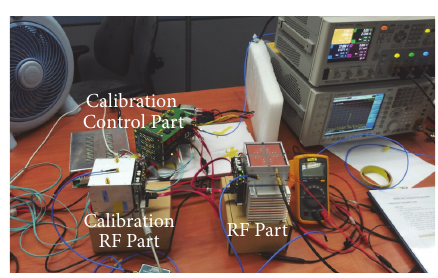
Figure 9: Photograph of implemented